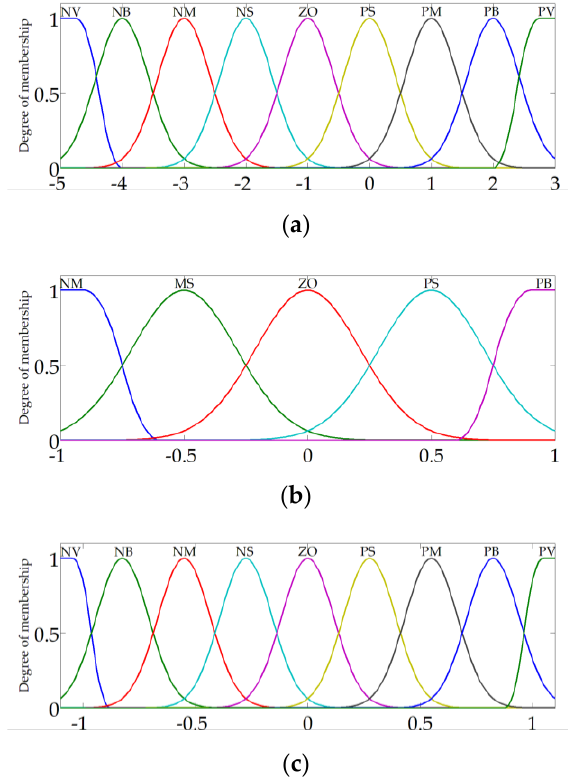
𝑑𝑣 𝑛 (𝑡) (𝑚/𝑠 2 ) ; ( b ) Acceleration pedal 𝑑𝑡 (cid:16) (cid:17) ( t ) m / s 2 ; ( b ) Acceleration pedal dt